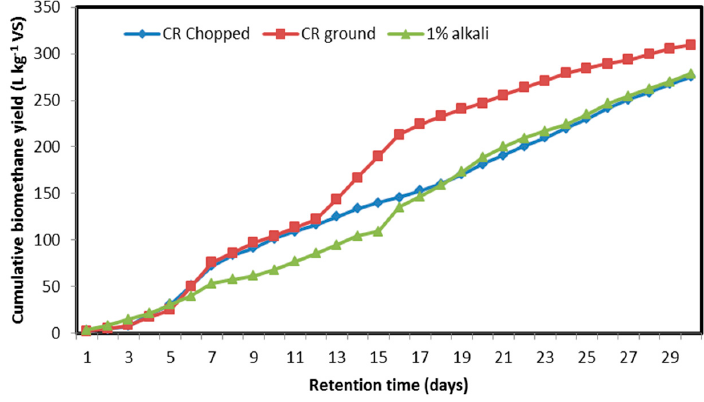
Figure 5. Cumulative biomethane yields of mechanical treated and 1% alkaline hydrothermal treated CR.